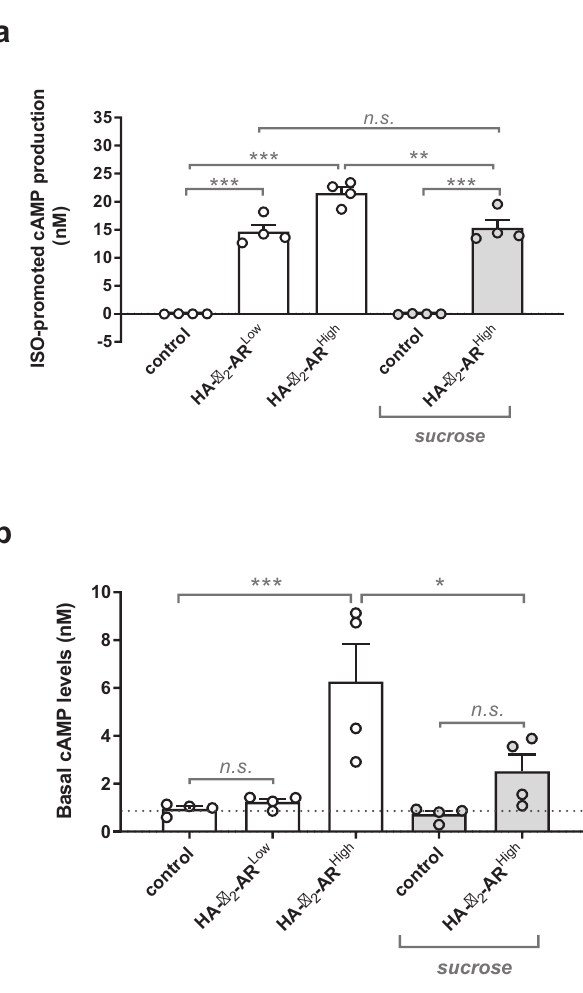
Fig. 2 Agonist-dependent and agonist-independent HA- β 2 -AR activity in WTT-CHO cells. a WTT-CHO cells were transfected with different amounts (0.1 or 1 µ g) of HA- β 2 -AR-encoding vector (HA- β 2 -AR Low and HA- β High respectively) or the empty vector (control) and cAMP 2 -AR production was quanti fi ed following stimulation with 10 µ M isoproterenol (ISO) for 30 min ( a ) or at basal state ( b ). When indicated, cells were pretreated with 200 mM sucrose for 1 h to prevent the receptor internalization process. Data represent the mean ± s.e.m. of four independent experiments, each performed in triplicates. The results are expressed as the difference in cAMP level measured in the presence and absence of isoproterenol (isoproterenol-promoted cAMP production) ( a ) or as basal cAMP levels ( b ). The statistical comparison was assessed using one-way ANOVA followed by Sidak ’ s multiple comparisons tests (* p < 0.05; ** p < 0.01; *** p < 0.001; n.s. not statistically signi fi spatial arrangement (Supplementary Fig. 5), only one area/cell was analyzed in the subsequent experiments.